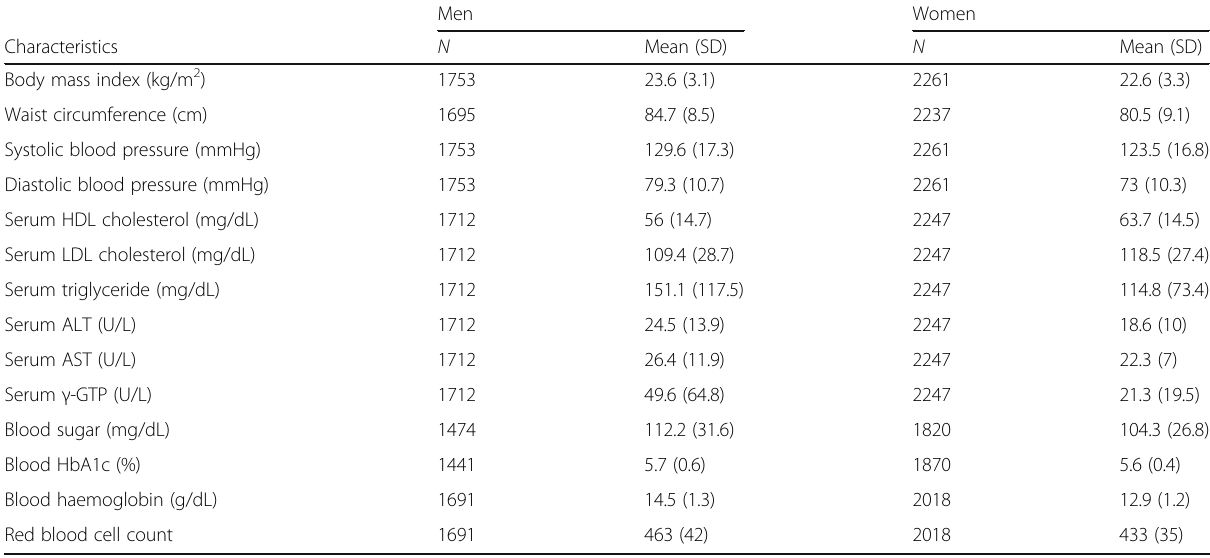
Table 5 Results of health check examinations ( N = 4014) Men Women Characteristics